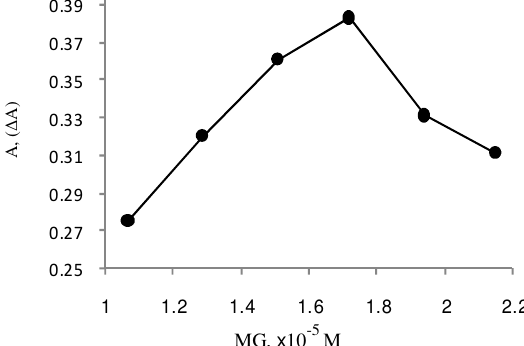
Figure 4. Effect of MG concentration on the sensitivity. Conditions:100 ng/mL V(V); H 0.8 M; Triton- x -100 ,0.01 M; BrO 3− , 8 ×10 -3 M; temperature, 23 °C and time of 2.0 min